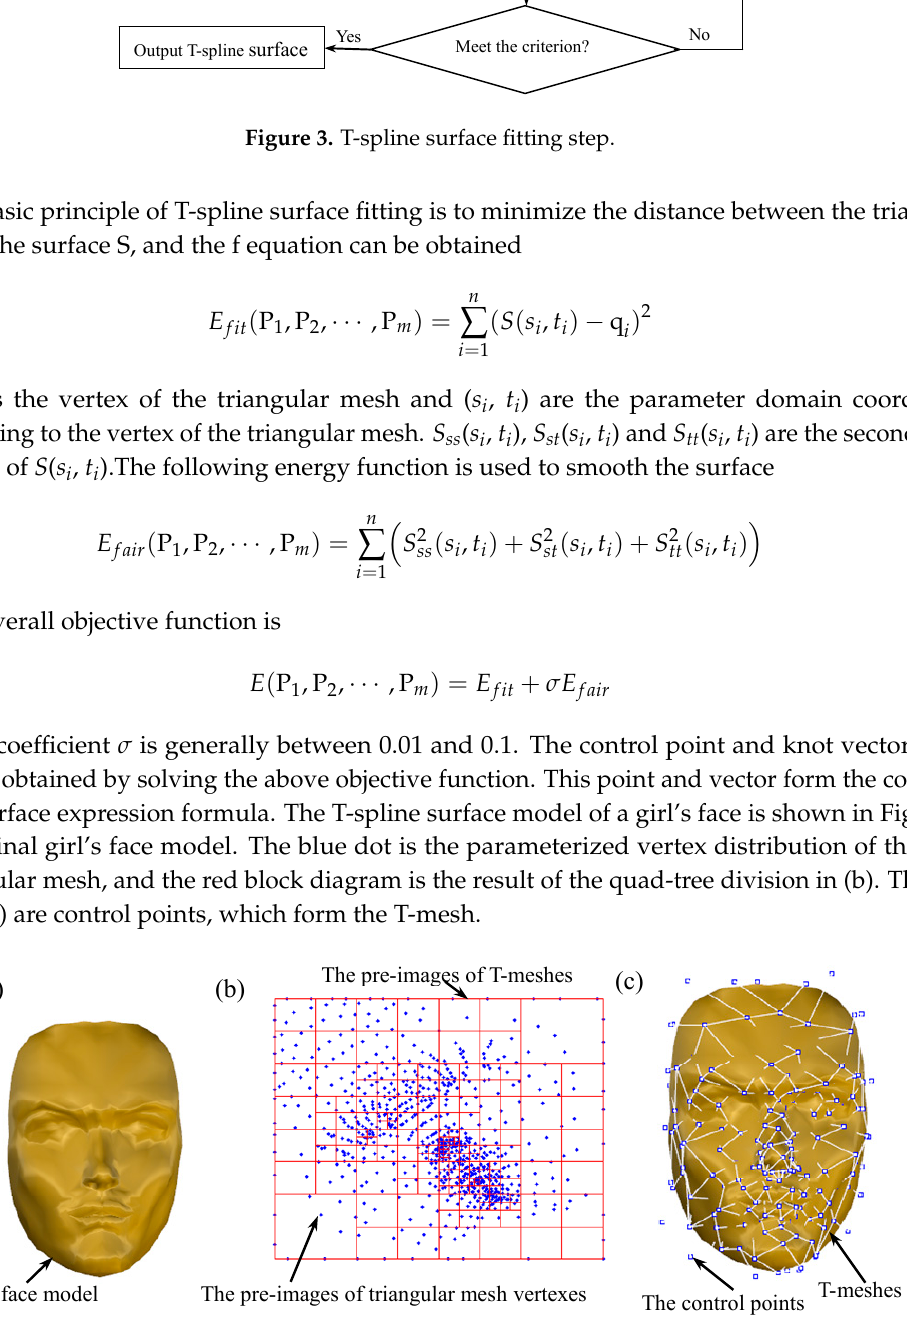
Figure 4. Girl’s face model as an example of fitting T-splines, ( a ) the original girl’s face model, ( b ) the pre-image of T-meshes and triangle mesh vertexes, ( c ) the spatial distribution of control points and T-meshes.